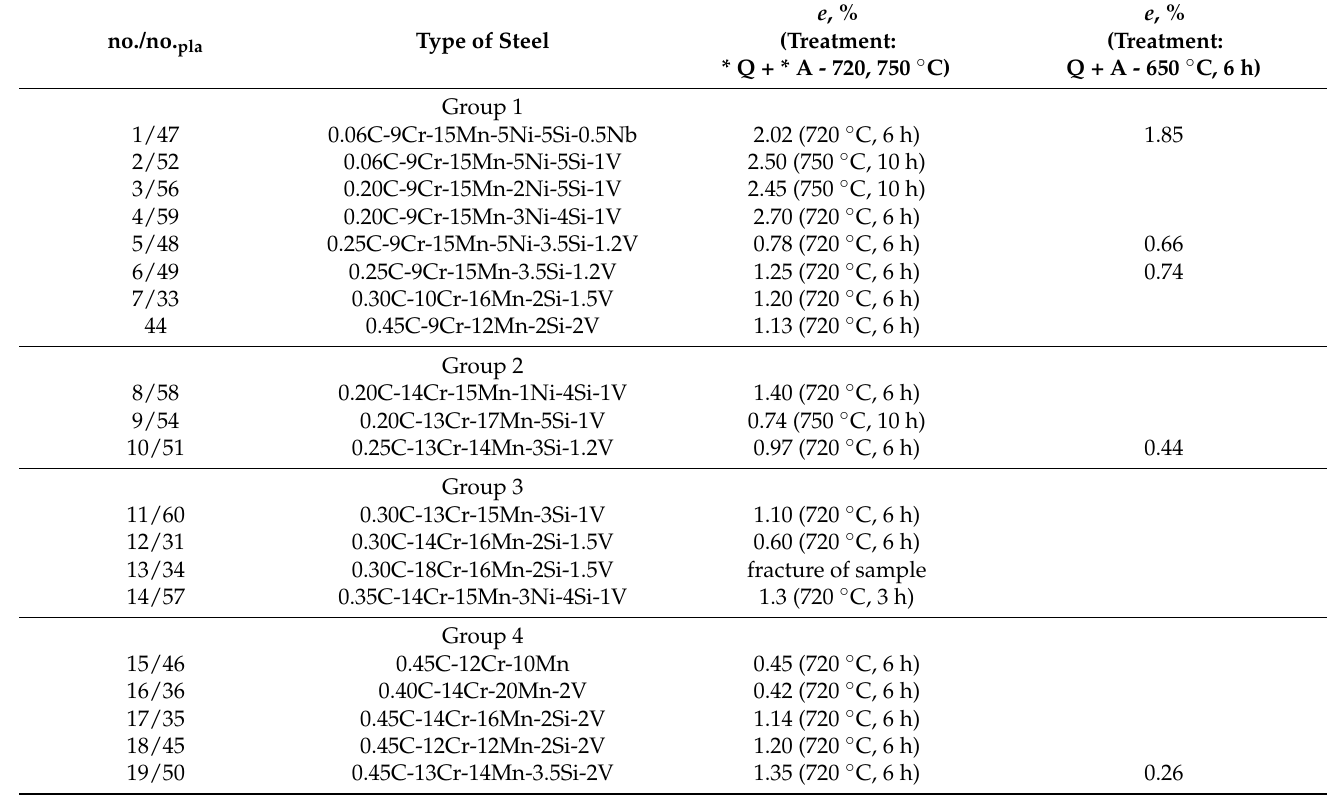
Table 2. Magnitudes (in %) of the SME in various stainless steels after different heat treatments